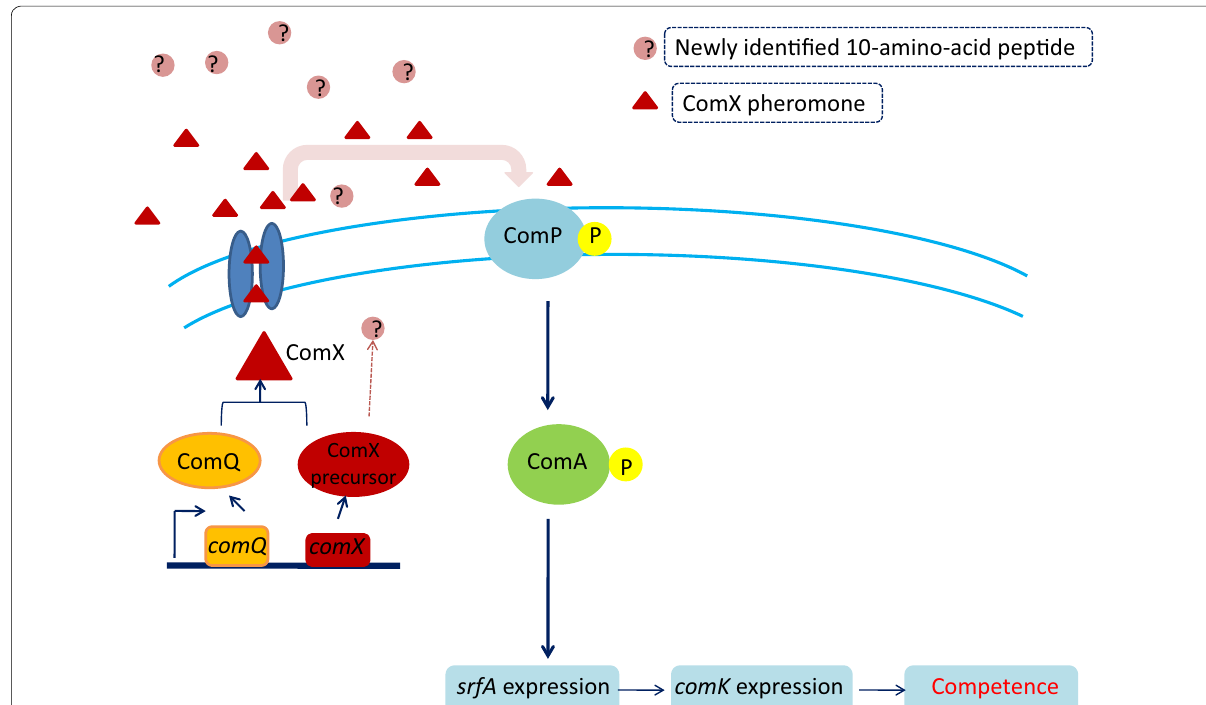
Fig. 5 A schematic model for regulation of competence through extracellular signalling peptide-mediated QS in B. licheniformis . The ComX precur- sor is processed and secreted by ComQ into at least two separate peptides, one of which is the ComX pheromone. The transmembrane histidine kinase sensor protein (ComP) interacts with the ComX pheromone leading to phosphorylation of the ComA response regulator/transcription factor, which in turn drives transcription of the srf operon. The second peptide (marked ‘?’) has been identified in this study as a 10-amino-acid long com- ponent of the ComX precursor. The role of this new peptide is presently